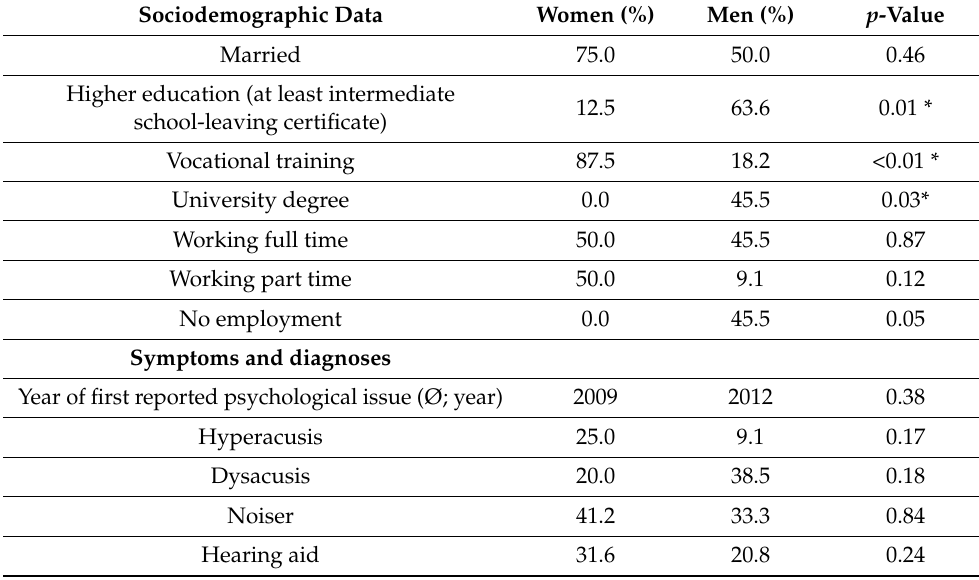
Table 2. Overview of gender differences regarding sociodemographic data, psychiatric diagnoses, and related symptoms in the subsample of participants with tinnitus and insomnia. * significant difference with p <